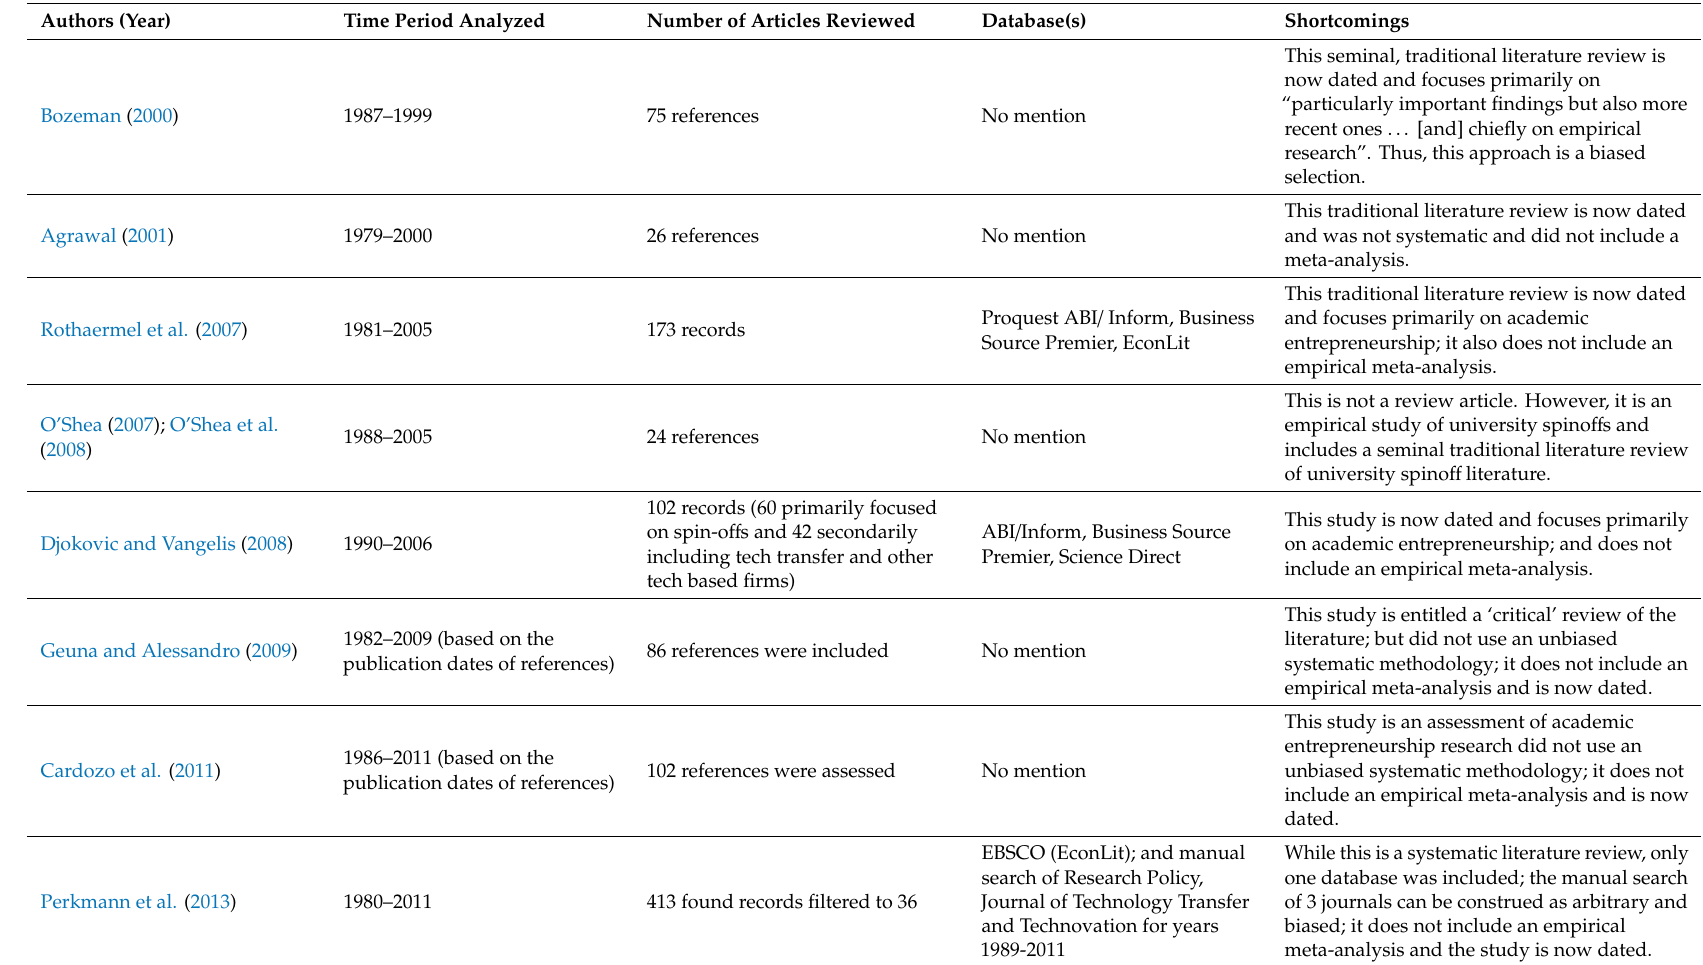
Table 3. Summary of methods used in past reviews of the